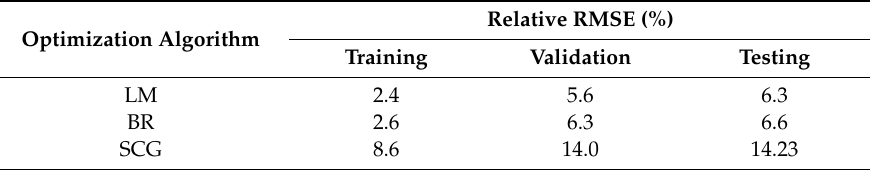
Table 3. Relative RMSE of the model for di ff erent optimization algorithms Optimization